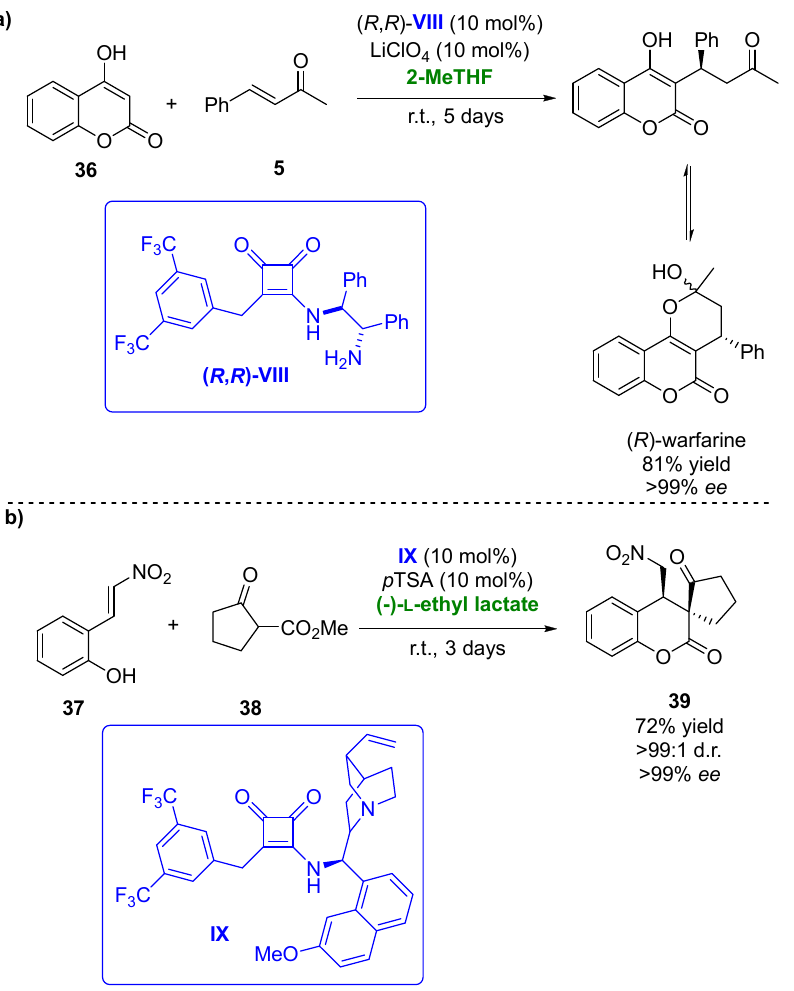
Figure 20. ( a ) Organocatalyzed synthesis of ( R )-warfarin in presence of biobased solvents. ( b ) Michael addition and cyclation of 2-(2-nitrovinyl)phenols with β -ketoesters catalyzed by squaramide IX in biobased solvents.